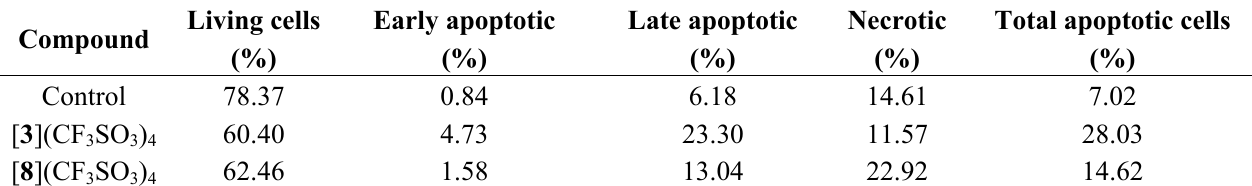
Table 3. Percentages of alive, early apoptotic, late apoptotic and necrotic A-549 cells